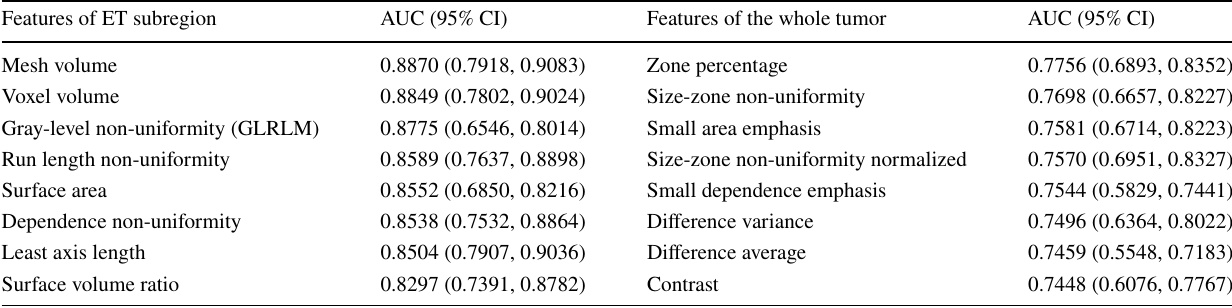
Table 2 Comparative results of AUC of the eight top-ranked features from the FLAIR-based ET subregion and whole tumor for glioma grade Features of ET subregion